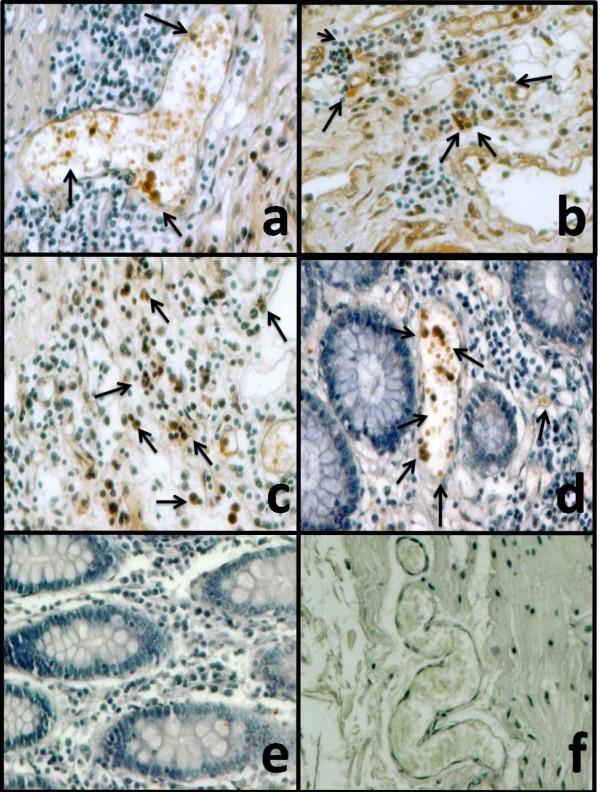
TLR9 increased detection in positive infiltrating immune cells in active UC. Representative immunoperoxidase analysis of TLR9 expression of inflamed colonic tissue from six patients (panel A-D) uninflamed colonic tissue (panel E-F) and taken from a representative patient with UC. In the negative controls (neg. ctrl), the secondary antibody was omitted. Original magnification was 20 × (panels A, C, D).